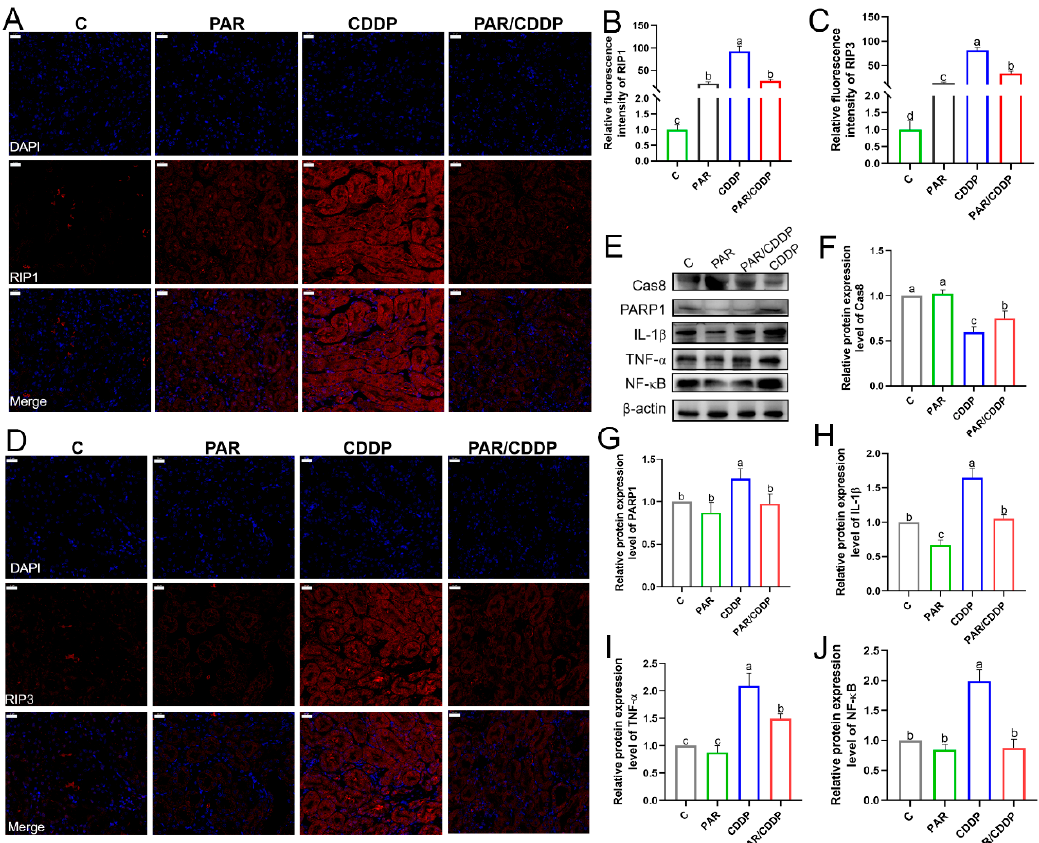
Figure 4. Paricalcitol reduced necroptosis and inflammation in cisplatin-treated mice kidneys. ( A – D ) Immunofluorescence representative images and quantification of RIP1 and RIP3 (scale bars, 20 μ m; n = 3). ( E – J ) Western blotting for Cas8, PARP1, IL-1 β , TNF- α and NF- κ B in the mice kidneys ( n = 3). C, control group; PAR, paricalcitol group; CDDP, cisplatin group; PAR/CDDP, paricalcitol + cisplatin group. Bars that do not share the same letters are significantly different ( p < 0.05) from each other. Results are presented as Mean ± SD. Statistical significance was obtained by one-way ANOVA.